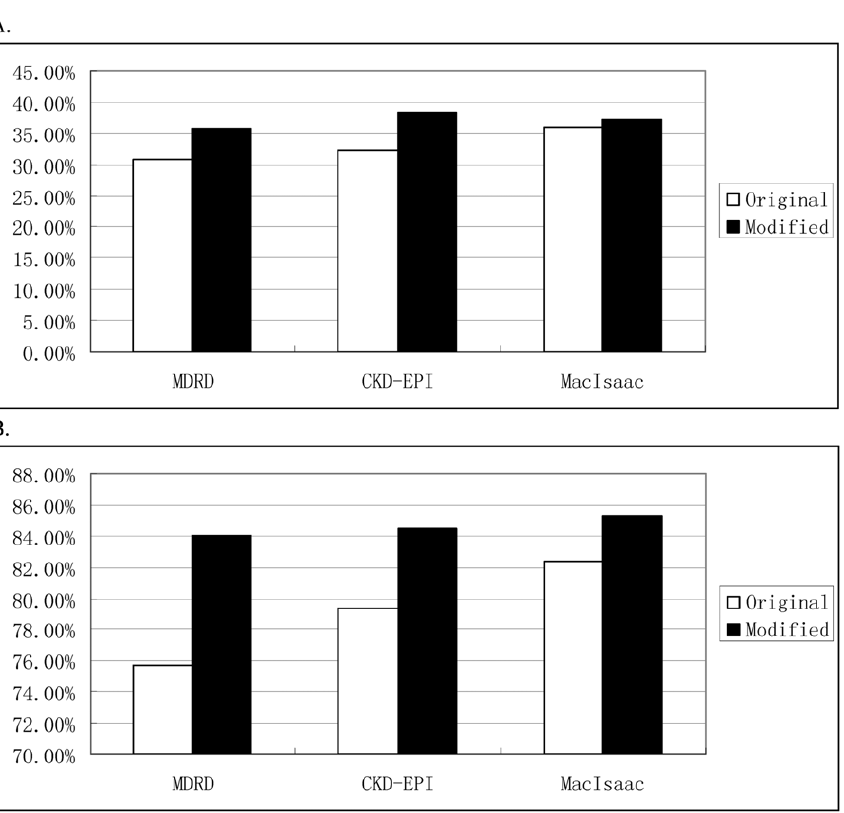
Figure 2. Comparison of accuracy of MDRD, CKD-EPI and MacIsaac equations before and after modification. A and B represent the percentage of eGFR deviating within 10% and 30% of rGFR, respectively. MDRD: Modification of Diet in Renal Disease; CKD-EPI: Chronic Kidney Disease Epidemiology Collaboration; eGFR: estimated glomerular filtration rate; rGFR: reference glomerular filtration rate; white column: original equation; black column: modified